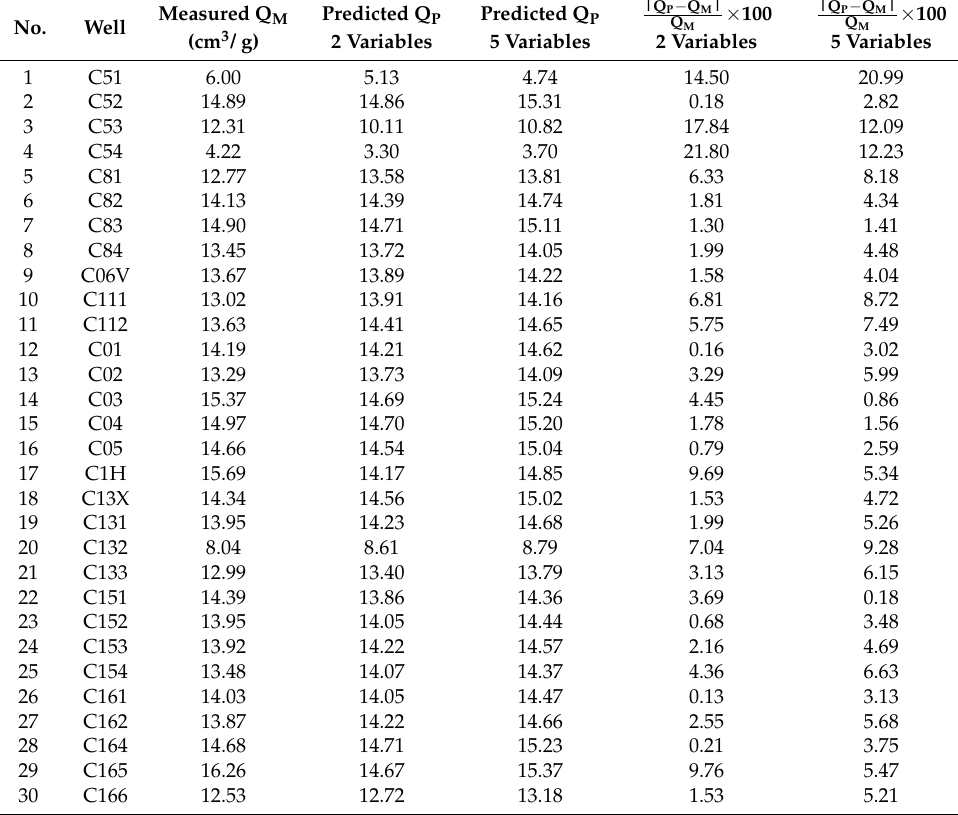
Table 4. Measured and predicted gas contents and error analysis.